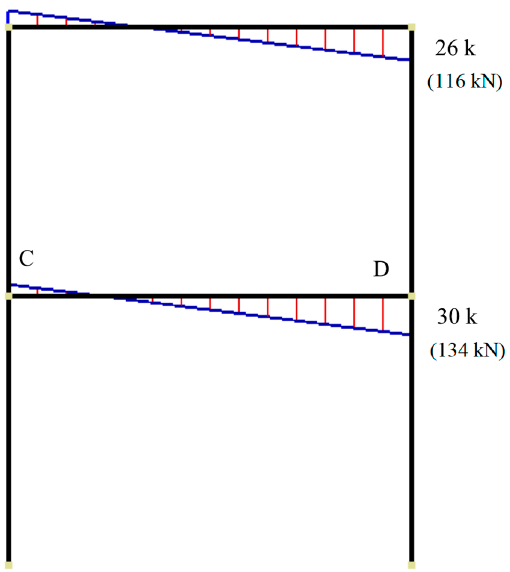
Figure 3. Factored design shear V ub for beams in accordance with ASCE/SEI-7-16 (18.4.2.3).